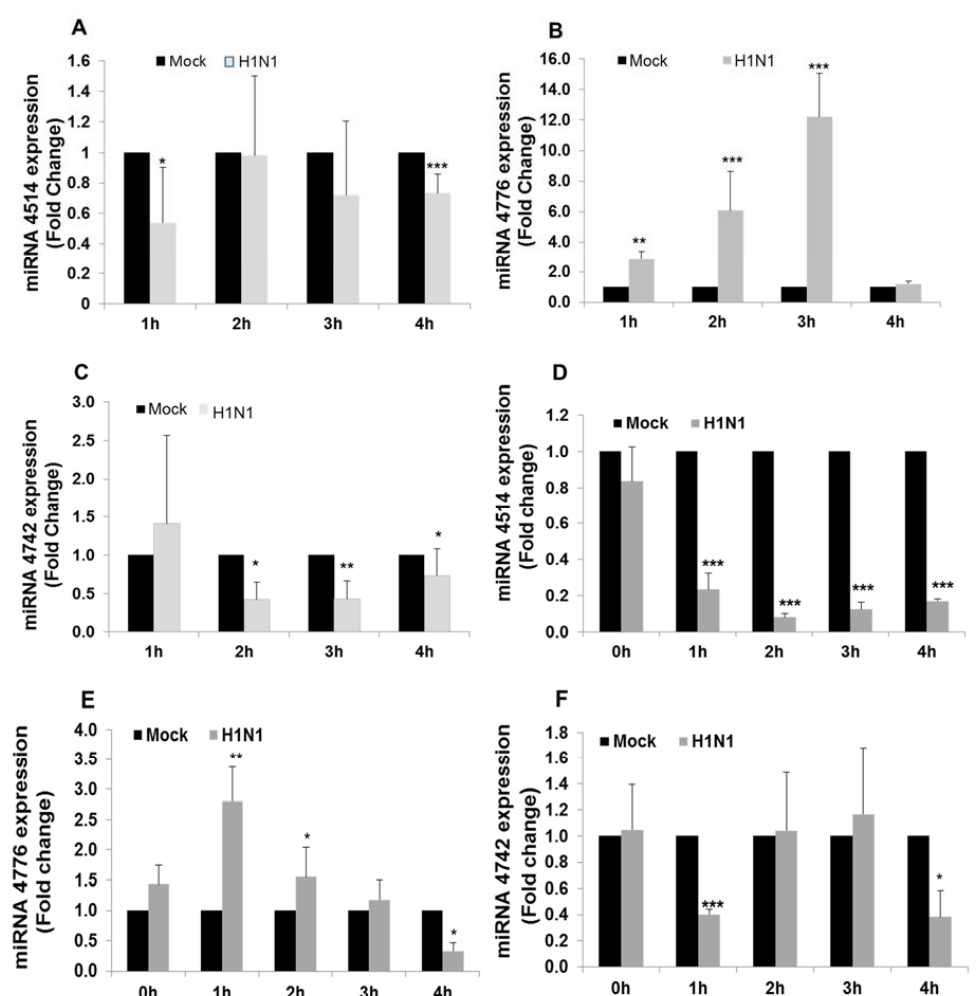
Figure 3. miRNA expression profile on exposure to IAV compared with mock and infected cells. ( A ) expression pattern of miR-4514. A549 cells were infected with IAV at multiplicity of infection (MOI) of 1 for 4 h and samples were taken every hour, miRNAs extracted and analyzed by reverse transcription-polymerase chain reaction (RT-PCR). *** p < 0.001; ( B ) expression pattern of miR-4776. A549 cells were infected with IAV at MOI of 1 for 4 h and samples were taken every hour, miRNAs extracted and analyzed by RT-PCR. ** p < 0.01, *** p < 0.001; ( C ) expression pattern of miR-4742. A549 cells were infected with IAV at MOI of 1 for 4 h and samples were taken every hour, miRNAs extracted and analyzed by RT-PCR. Data is from three independent experiments. * p < 0.05, ** p < 0.01; ( D ) expression pattern of miR-4514. Human bronchial epithelial cells (HBEpCs) infected with IAV at MOI 1 for 4 h and samples were taken every hour, miRNAs extracted and analyzed by RT-PCR. Data is from three independent experiments. *** p < 0.001; ( E ) expression pattern of miR-4776. HBEpCs were infected with IAV at MOI of 1 for 4 h and samples were taken every hour, miRNAs extracted and analyzed by RT-PCR. Data is from three independent experiments. * p < 0.05, ** p < 0.01; and ( F ) expression pattern of miR-4742. HBEpCs were infected with IAV at MOI of 1 for 4 h and samples were taken every hour, miRNAs extracted and analyzed by RT-PCR. Data is from three independent experiments. * p < 0.05, *** p < 0.001. Expression of each miRNA was normalized to expression of U6